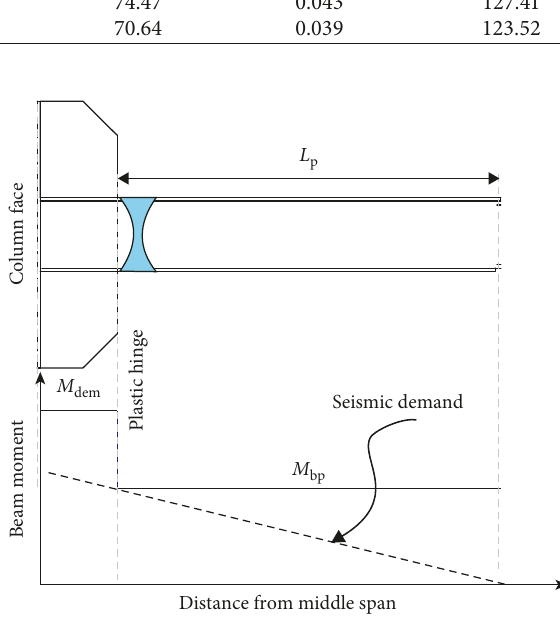
Figure 11: Bending moment diagram of the connection.